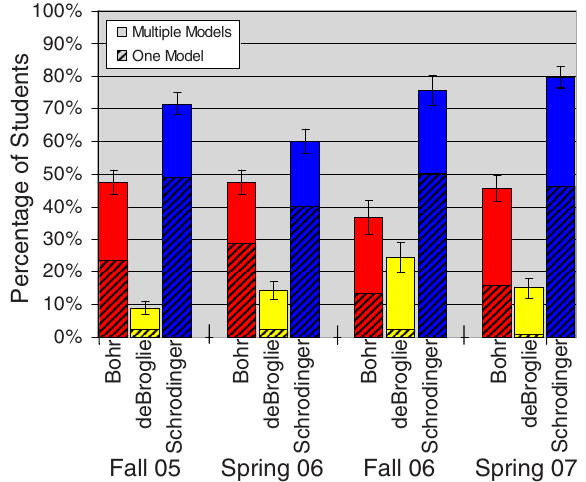
FIG. 2. (cid:1) Color (cid:2) Models used to describe hydrogen atom (cid:1) either implicitly or explicitly (cid:2) . The lower section of the bar for each model indicates the percentage of students who used that model exclu- sively, while the upper section indicates the percentage of students who used that model along with at least one of the other two mod- els. The total height of each bar thus indicates the total percentage of students who used each model, whether exclusively or not. These percentages include only students who discussed the corresponding models as valid and without limitations. Error bars represent the standard error on the mean for the total height of each bar. N =179, 175, 90, and 147 for each of the respective semesters.